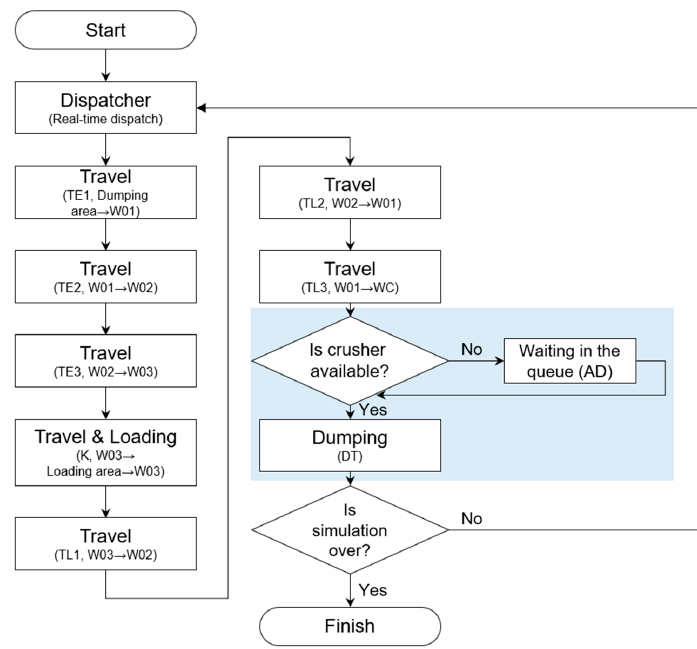
Figure 5. Flow chart showing procedures for implementing the truck haulage simulation algorithm.